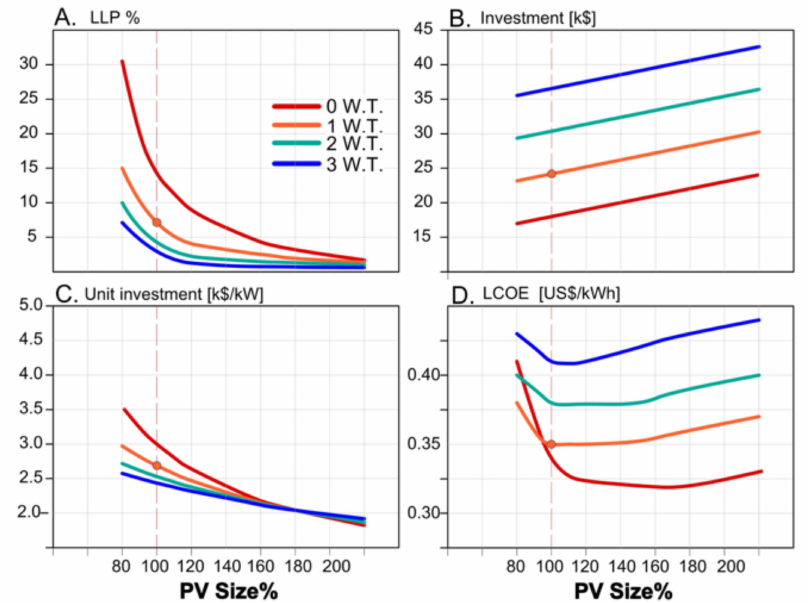
Figure 12. ( A ): LLP for varying sizes of PV arrays and number of wind turbines with a fixed demand and VRLA-GEL battery bank size of 38.4 kWh; ( B ): investment for varying sizes of PV arrays and number of wind turbines with a fixed demand and VRLA-GEL battery bank size of 38.4 kWh; ( C ): unit investment for varying sizes of PV arrays and number of wind turbines with a fixed demand and VRLA-GEL battery bank size of 38.4 kWh; ( D ): LCOE for varying sizes of PV arrays and number of wind turbines with a fixed demand and VRLA-GEL battery bank size of 38.4 kWh (present situation is shown with a